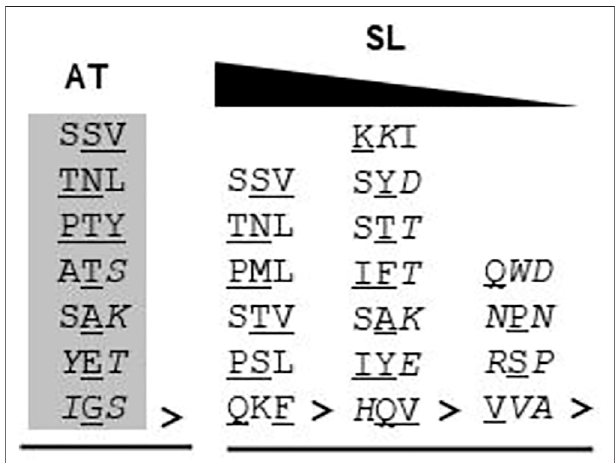
FIGURE 4 | C-terminus tripeptide without any “ obvious ” PTS in Arabidopsis thaliana and Solanum lycopersicum : The C-terminus tripeptides which do not fall under either canonical or non-canonical categories were put under this. Gray highlighted tripeptide: demonstrated peroxisomal localization by fl uorescent fusion construct; “ > ” indicates the end of the peptide sequence; underlined residue: non-canonical residue; italicized residue: amino acid not demonstrated to be functional PTS1; AT, Arabidopsis thaliana ; SL, S . lycopersicum . For S . lycopersicum , no wet-lab data are available. The triangle at the top indicates the reducing propensity of tripeptides to be functional PTS1 from left to right.